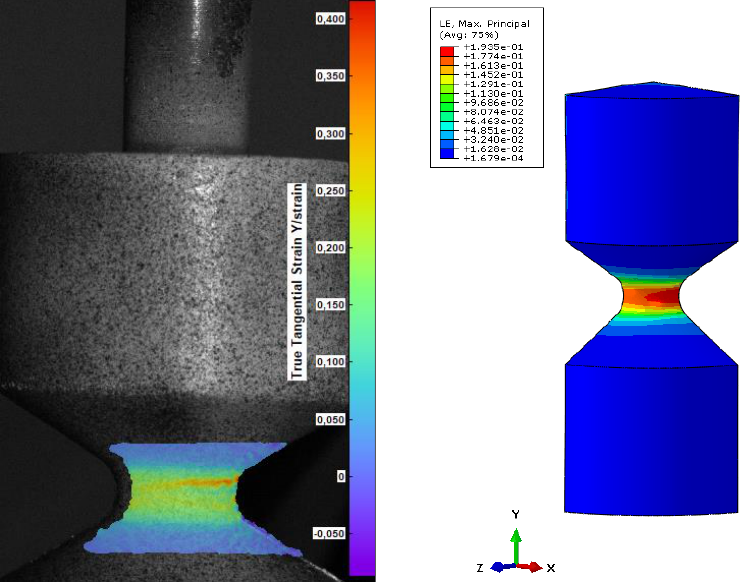
Figure 12. Comparison of DIC and FEM in terms of the obtained value of strain for step 30 (force DIC = 465 N, FEM force = 468 N).